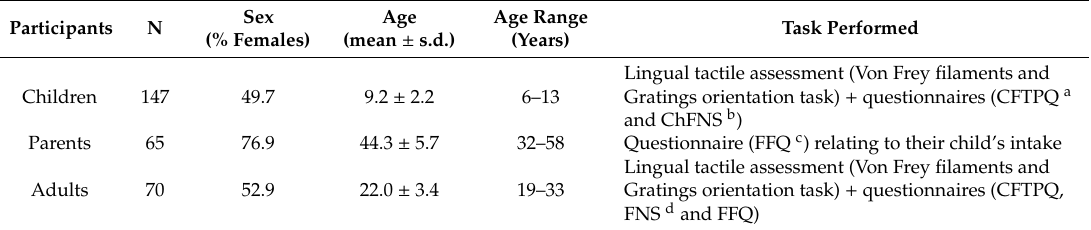
Table 1. Characteristics of the participants and tasks performed in the